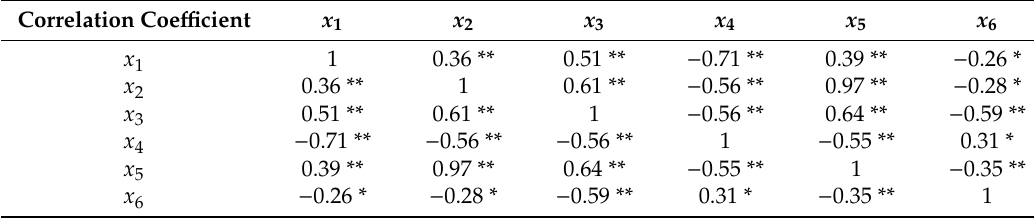
Table 7. Correlation coe ffi cient matrix of influential factors.